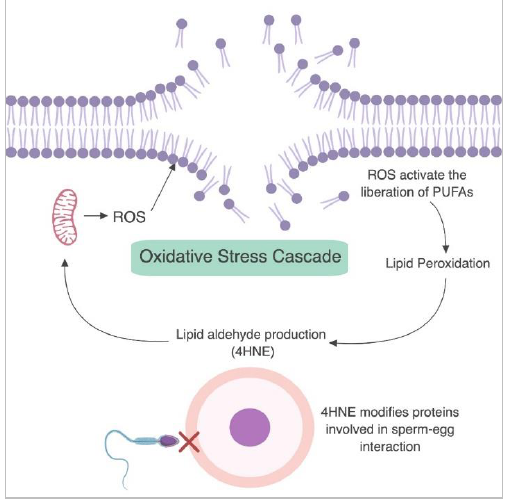
Figure 1. The cascade of oxidative stress in human spermatozoa. Mitochondrial reactive oxygen species (ROS) are produced and initiate the breakdown of the lipid plasma membrane. This promotes lipid peroxidation and the production of cytotoxic lipid aldehydes such as 4-hydroxynonenal (4HNE). In turn, 4HNE upregulates ROS production while causing an overall decline in cell function, ultimately impairing sperm-egg interaction. Figure created with